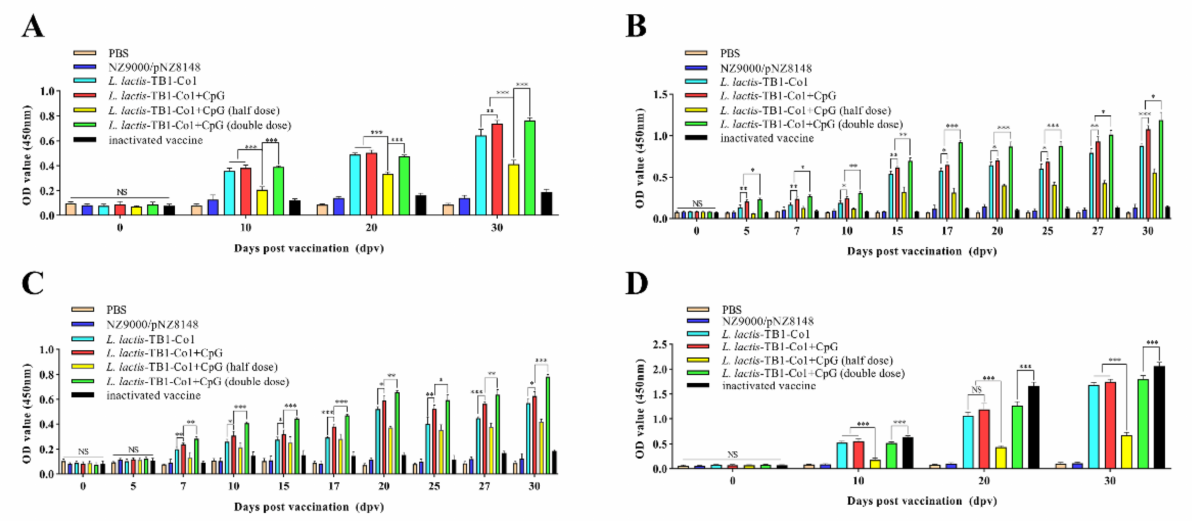
Figure 3. Titers of FMDV-specific antibodies in guinea pigs. ( A ) IgA levels in serum on days 0, 10, 20, and 30. ( B ) SIgA levels in anal swabs on days 0, 5, 7, 10, 15, 17, 20, 25, 27, and 30. ( C ) SIgA levels in saliva on days 0, 5, 7, 10, 15, 17, 20, 25, 27, and 30. ( D ) IgG antibody levels in serum on days 0, 10, 20 and 30. Data are shown as mean ± SD. Analyses were performed by multiple t tests (NS = p > 0.05; * p < 0.05; ** p < 0.01; *** p <